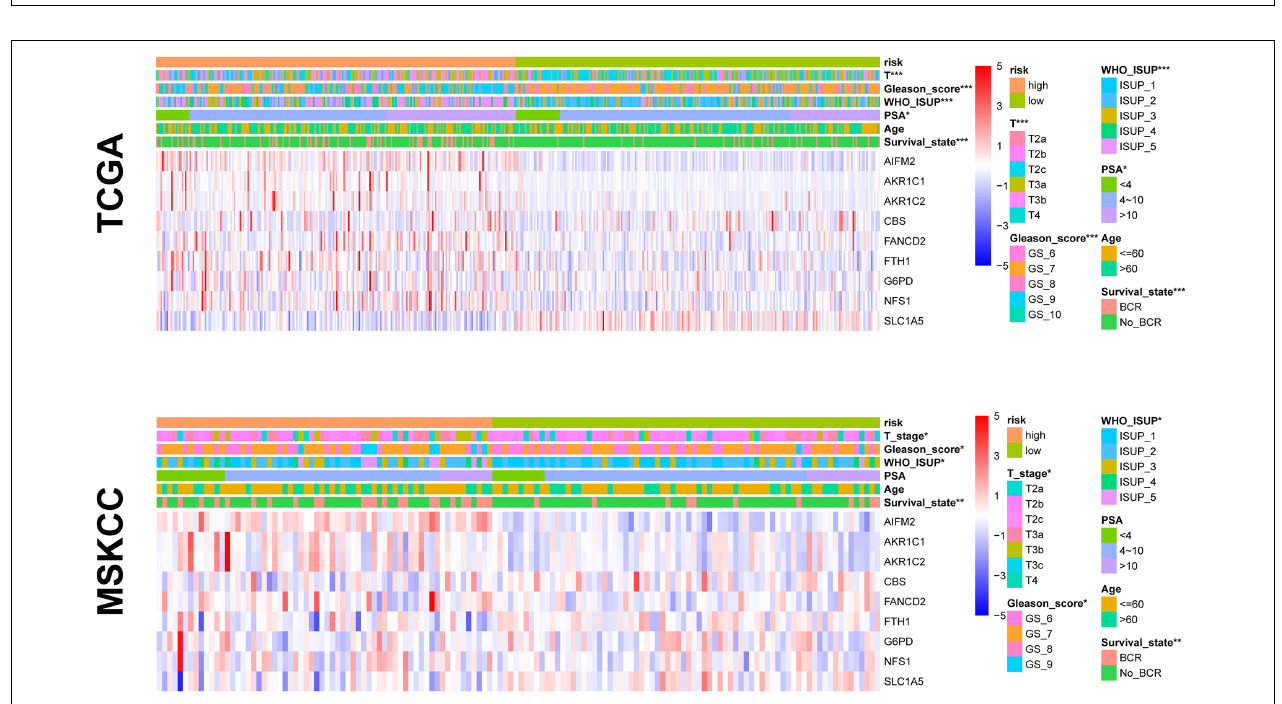
FIGURE 6 | The relationship between prognosis and clinicopathological parameters in two cohorts (* p < 0.05; ** p < 0.01; *** p < 0.001).